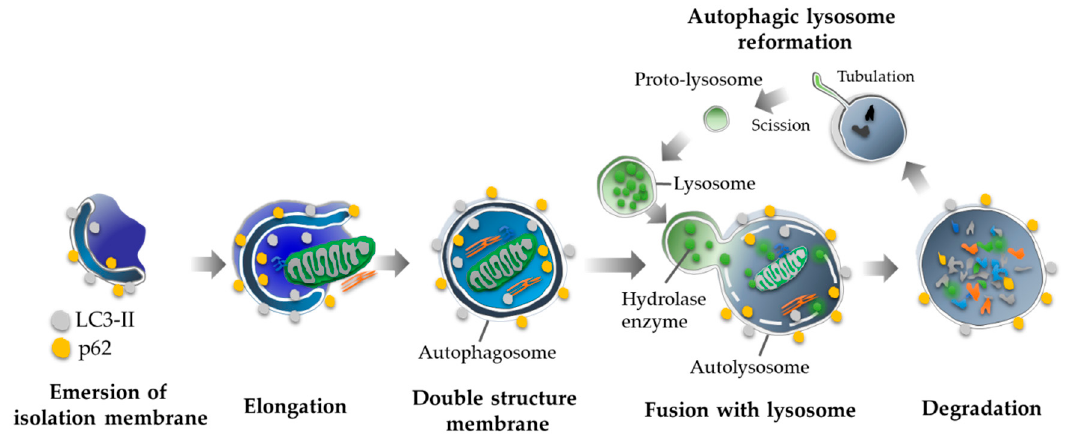
Figure 1. Autophagy cascade. An isolation membrane is merging in cytoplasm via PI3K complex. After elongation of the membrane, the isolation membrane closes and completes the autophagosome, which is formed with double membranes. Finally, the autophagosome forms the autolysosome by fusing with the lysosome and digests the contents the inner membrane. Following with the degradation, autophagy provides matured lysosomes by a recycling of proto-lysosomal membrane components.